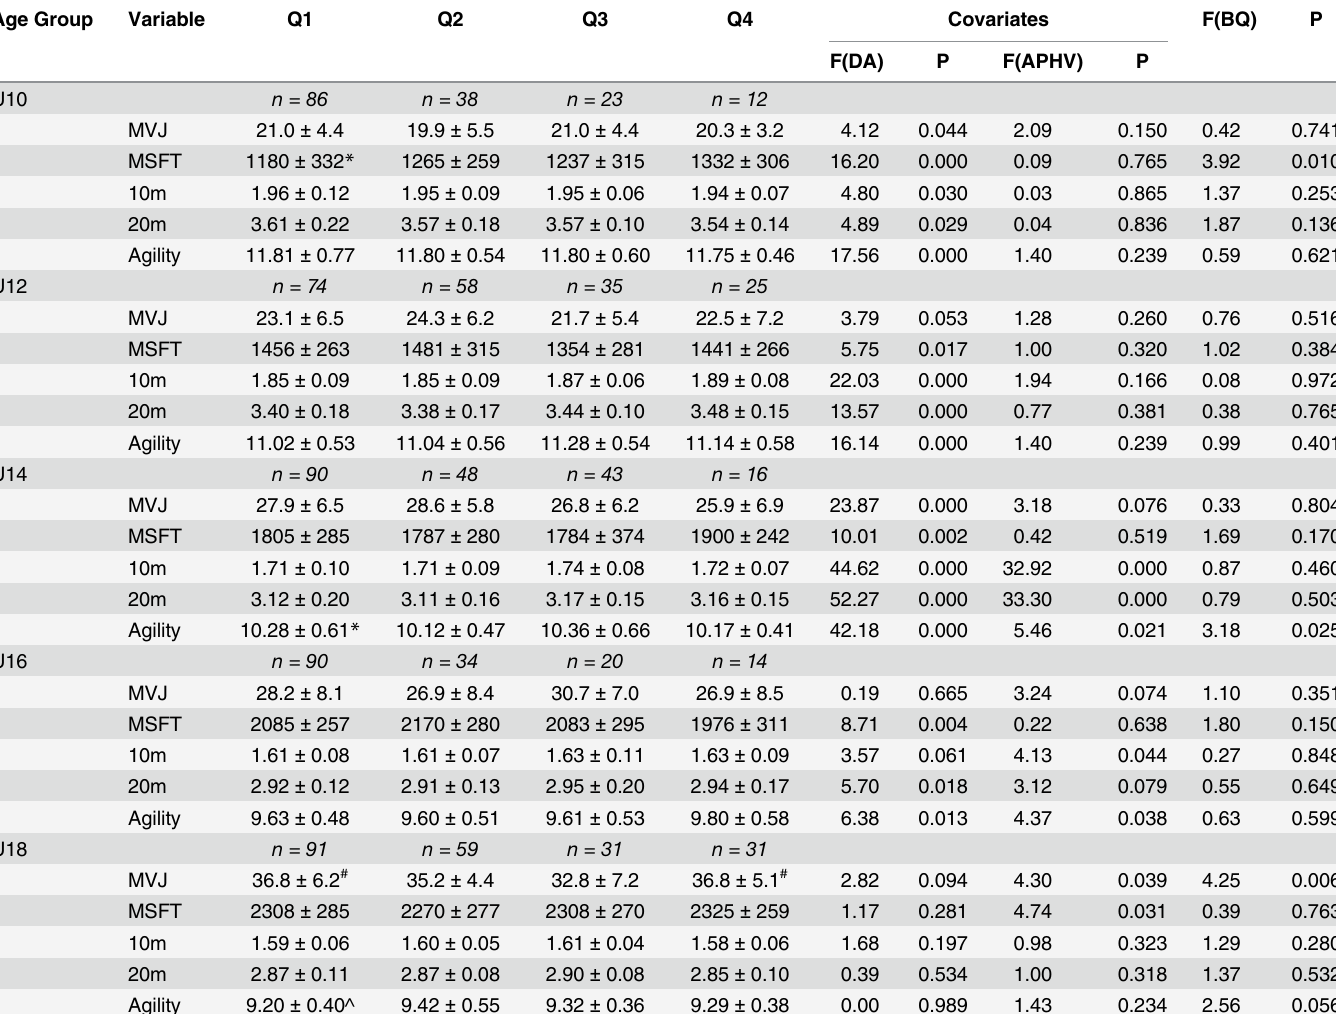
Table 3. Fitness capacities of junior soccer players according to relative age quartile & bi-annual age-groups.